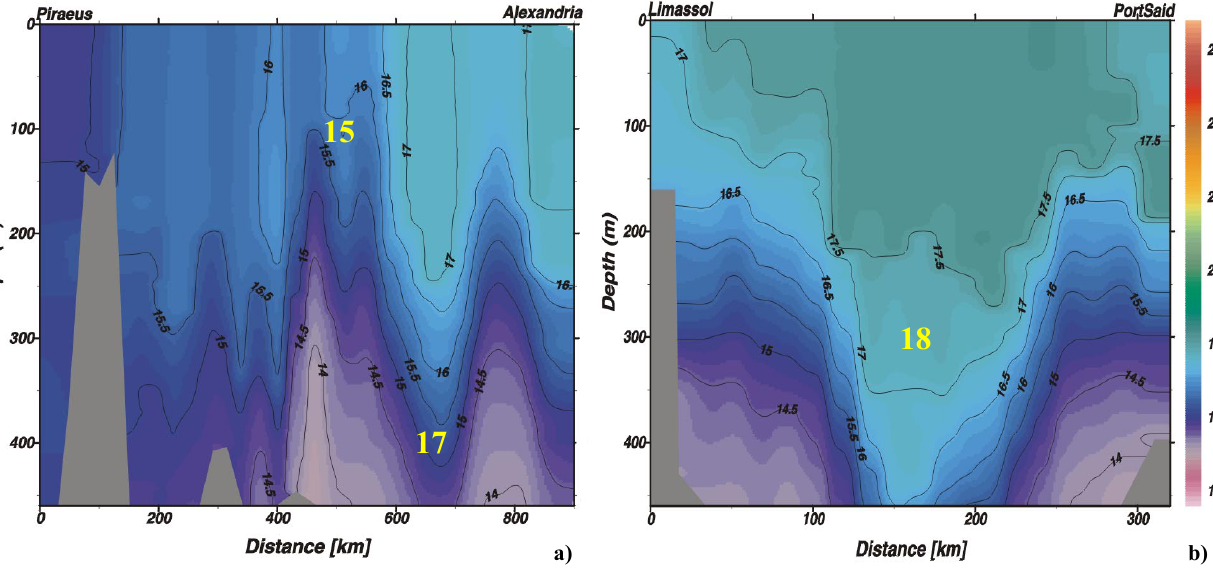
Fig. 5. Temperature vertical sections in February 2000 (a) from Piraeus to Alexandria (track 6), (b) from Limassol to PortSaid (track 7). Numbers and letters indicate the observed features (see also Fig. 1): 15-Ierapetra Anticyclone, 17-Mersa-Matruh Gyre, 18-Shikmona